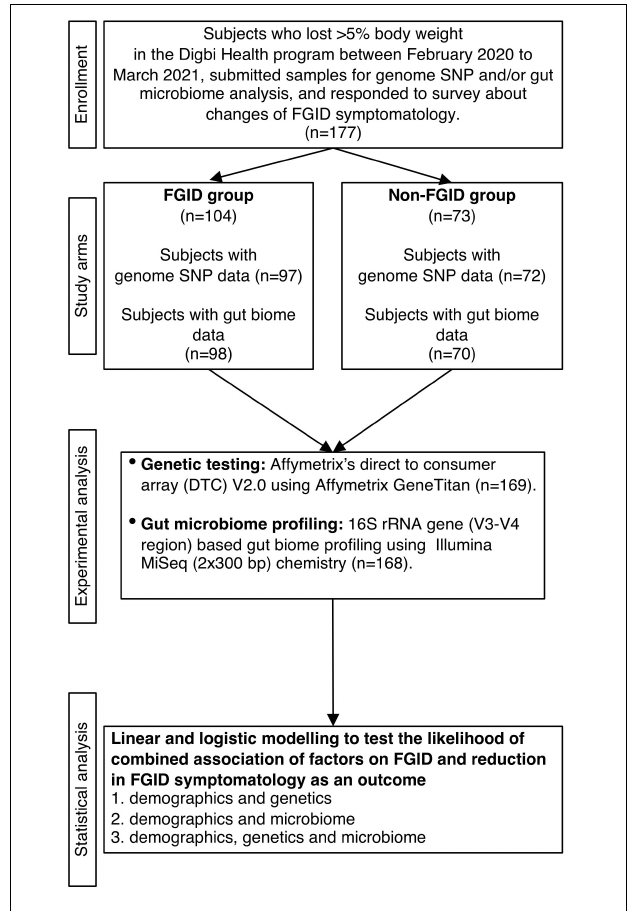
FIGURE 1 | Study design